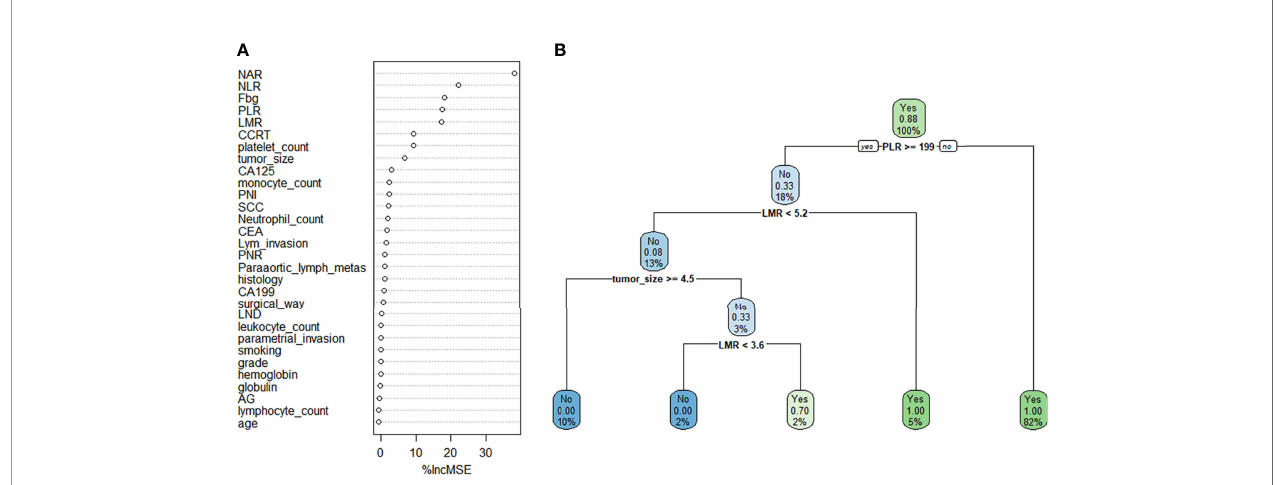
FIGURE 3 | Visualization of the predictive model based on ML-based algorithm. (A) RFC model. (B) DT model. Candidate factors associated with rNACT were ordered using the RFC algorithm (A) , and the prediction node and weight were allocated with the DT algorithm (B) .